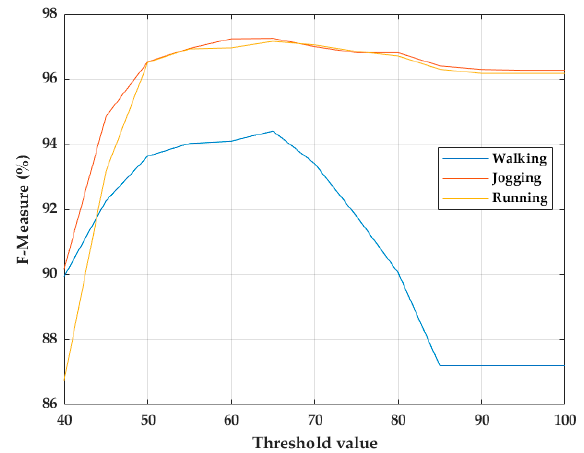
Figure 7. Threshold choice for stride segmentation of walking, jogging, and running strides using